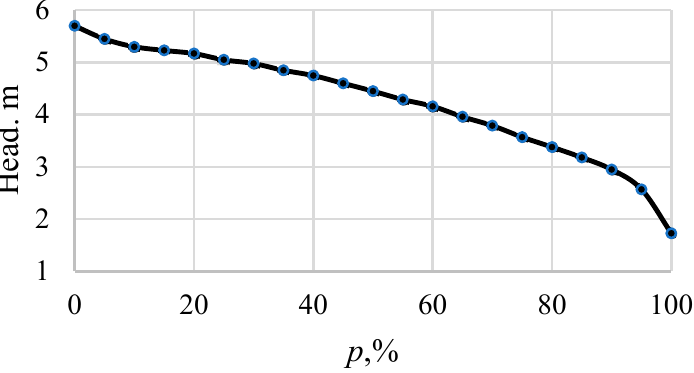
Figure 9. Head duration curve at the outlet of Kaunas WWTP (Kacergine); p —percentage of time equaled or exceeded. The receiving body is the Nemunas river.